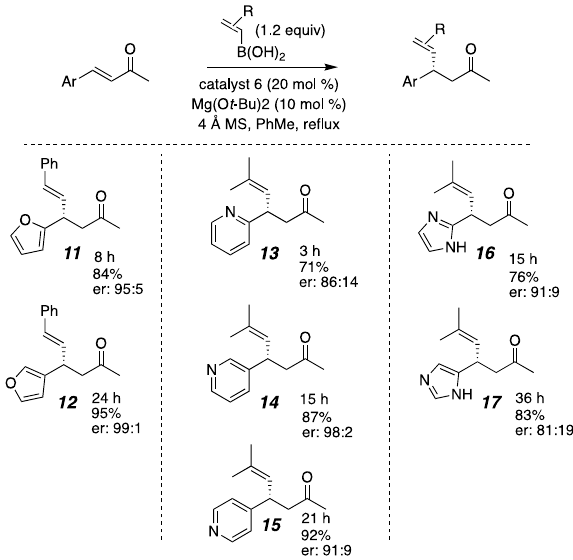
Figure 3. Reaction times for series of heteroaromatic substrates.